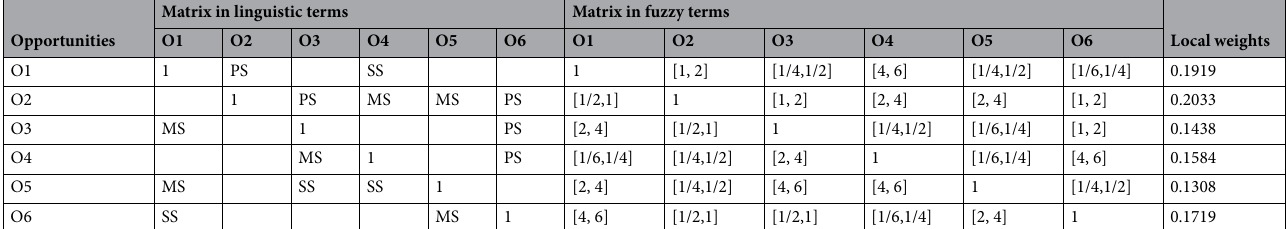
Table 6. Evaluation criteria of the opportunities. (C.R. = 0.093).